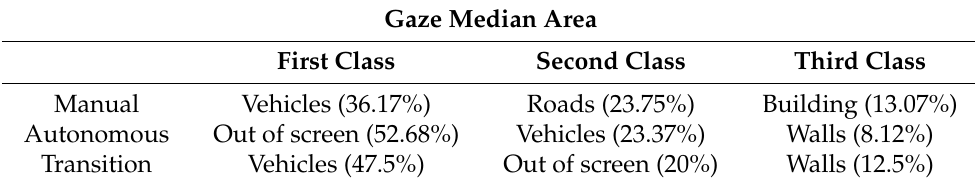
Table 2. Gaze focalization analysis with semantic